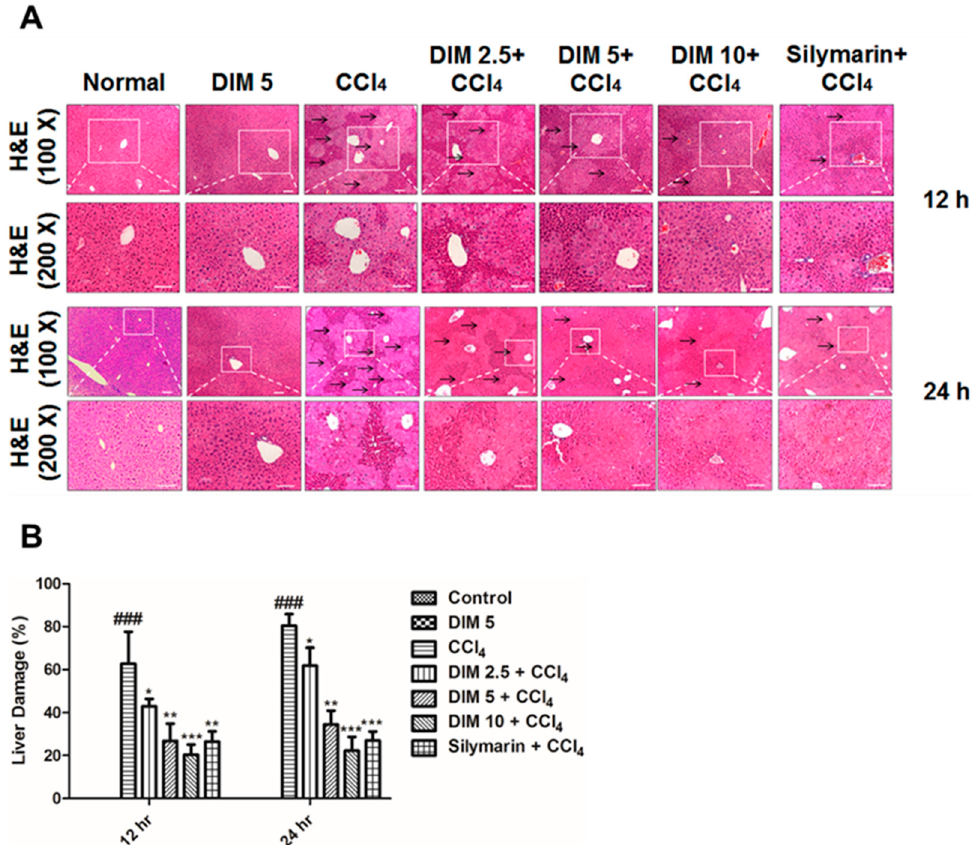
Figure 2. Effects of DIM on histopathological changes of liver tissues; the black arrow shows the necrotic area and liver damage ( A ) and the quantitative measurement (%) area of damage ( B ) of liver tissues after CCl 4 injection. The tissues were stained with H&E. The liver sections were observed at X100 and X200 magnification. The scale bar represents 50 and 100 μ m, respectively. Data are expressed as mean ± SD ( n = 5). ### p < 0.001 denotes significant differences compared to the normal control group , * p < 0.05, ** p < 0.01, *** p < 0.001 denotes significant difference compared to the CCl 4 group.